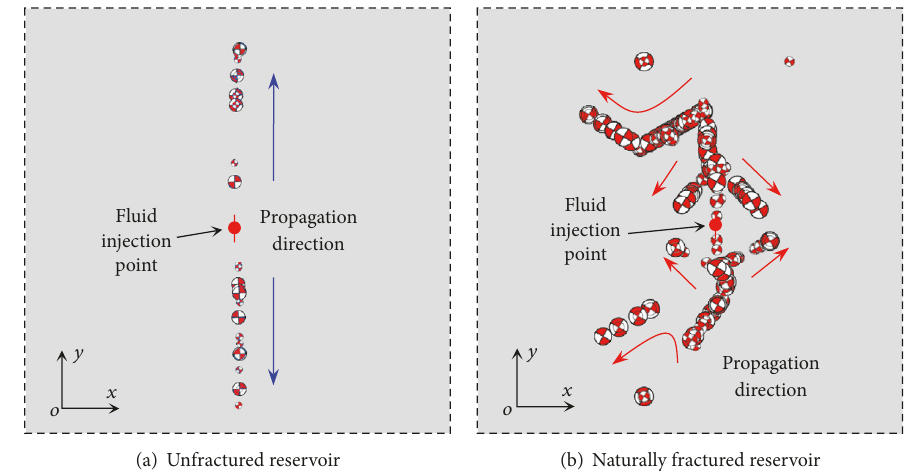
Figure 14: Focal spheres for distribution of final contact slip events.